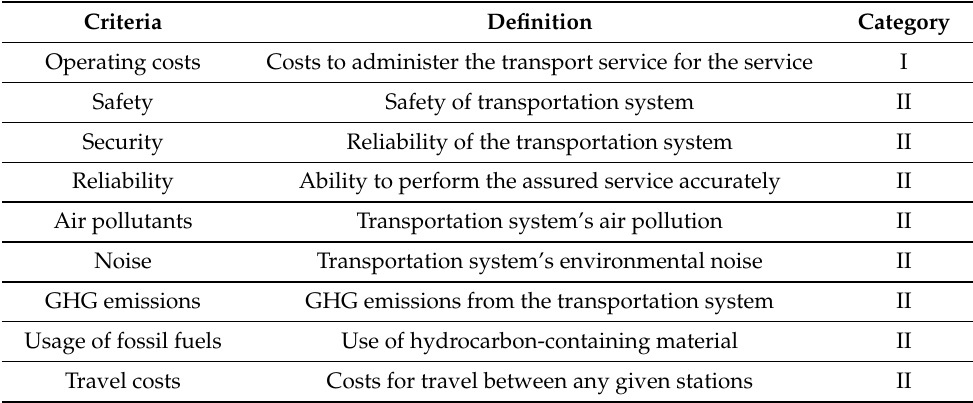
Table 3. I (cost), II (benefit). Criteria for evaluating the sustainability of transportation